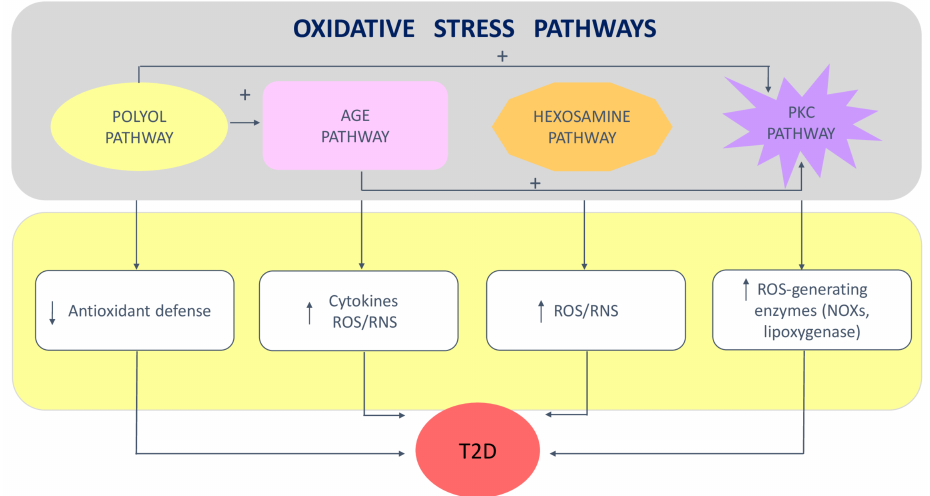
Figure 1. Key oxidative stress pathways in type 2 diabetes: Upper panel: some of these pathways are interconnected and promote other mechanisms generating oxidative stress; Lower panel: arrows represent an increase or a decrease in oxidative stress/inflammation-related biomarkers.